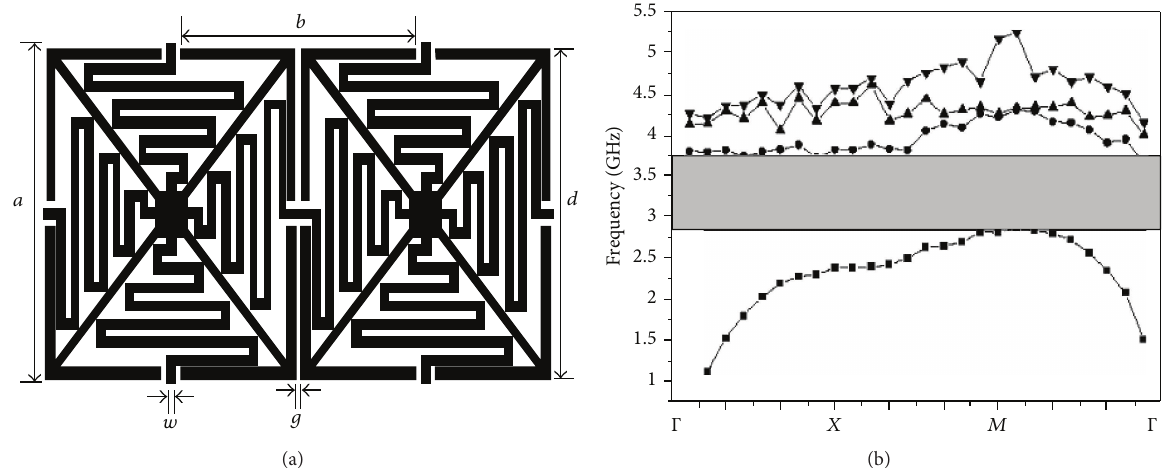
Figure 9: (a) The ameliorated UCEBG and (b) dispersion diagram.